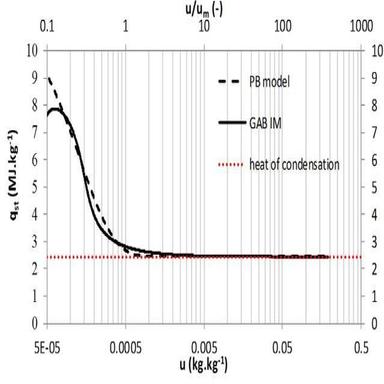
Evolution of the isosteric heat – The fitted parameters of PB model are k1 = 7.5 103 , k2 = 1.08 and k3 = 83.1.